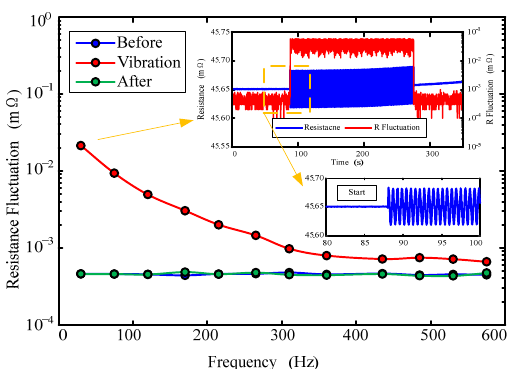
Figure 10. Contact resistance fluctuation variations with frequency.